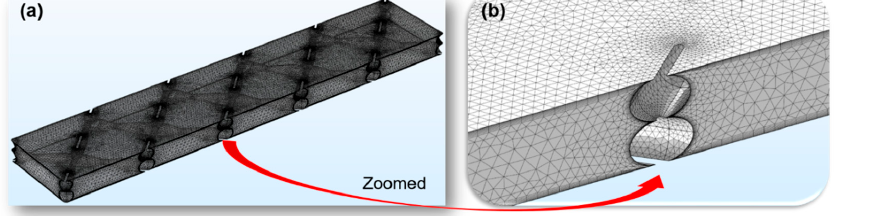
Figure 3. The geometric model discretization for ( a ) the computational domain and ( b ) the zoomed spacer section.